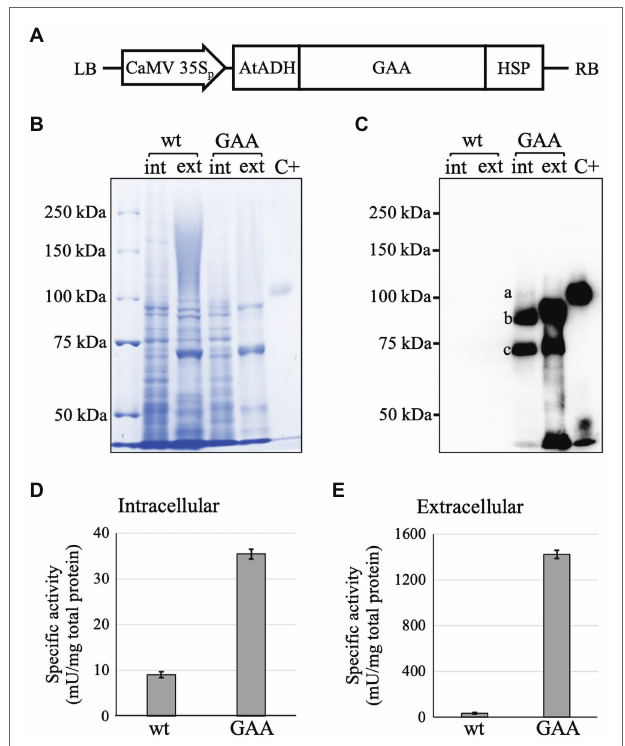
FIGURE 1 | Expression cassette and confirmation of acid-alpha glucosidase (GAA) production in the transformed Arabidopsis alg3 cell culture. (A) Schematic representation of pFK1-BAR-GAA. Cauliflower mosaic virus (CaMV) 35S p : CaMV 35S promoter; AtADH 5’-UTR: 5 ' -untranslated region of Arabidopsis alcohol dehydrogenase gene which acts as an enhancer; GAA: cDNA of human GAA; HSP: Arabidopsis heat shock protein terminator; and LB and RB: left and right borders of T-DNA, respectively. (B,C) CBB staining and Western blot analysis of untransformed (wt) and transformed (GAA) 7-day-old Arabidopsis alg3 cell culture to confirm GAA production intra (int)- and extracellularly (ext). Marks a, b, and c indicate the 110, 95, and 76 kDa GAAs, respectively. C+ is human embryonic kidney/HEK293-derived recombinant human GAA used as a positive control. (D,E) GAA-specific activities in crude intracellular and extracellular proteins of untransformed (wt) and transformed (GAA) Arabidopsis alg3 cell